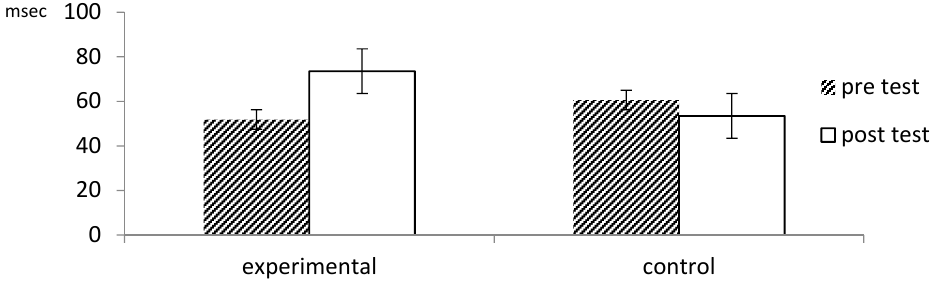
Figure 2. Effect on forest therapy on SDNN.